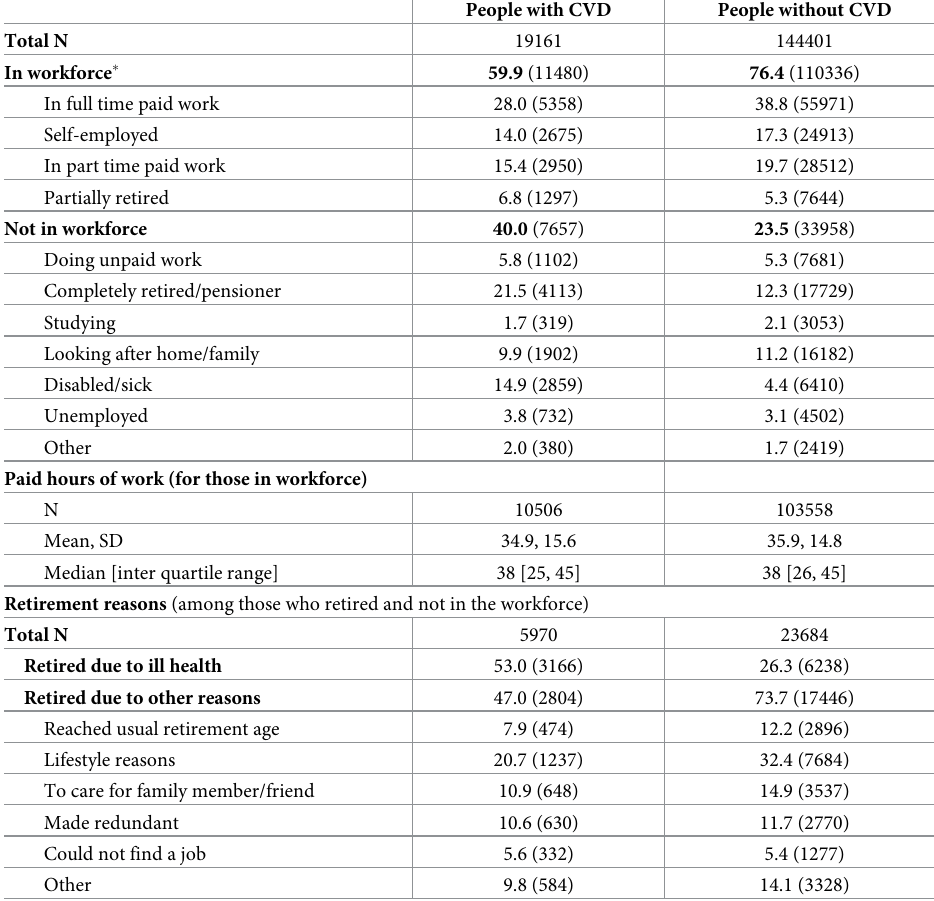
Table 2. Workforce participation, paid work hours per week, retirement patterns and physical functioning limita- tions among study participants. People with CVD People without